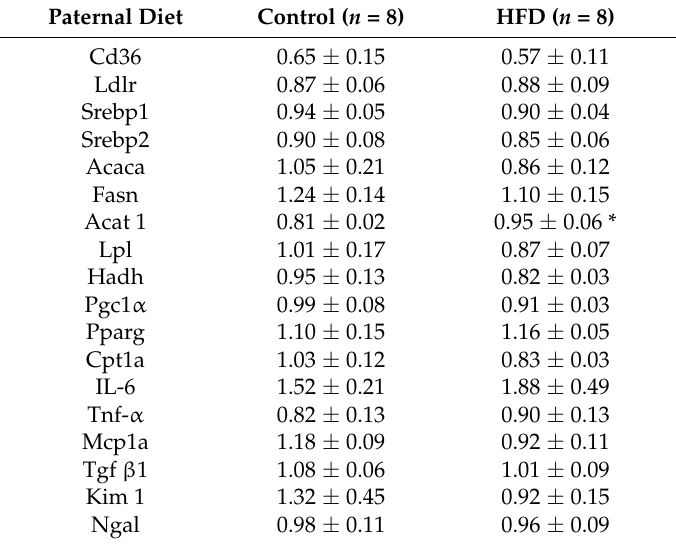
Table 3. Renal gene expression of offspring at 27 weeks of age.